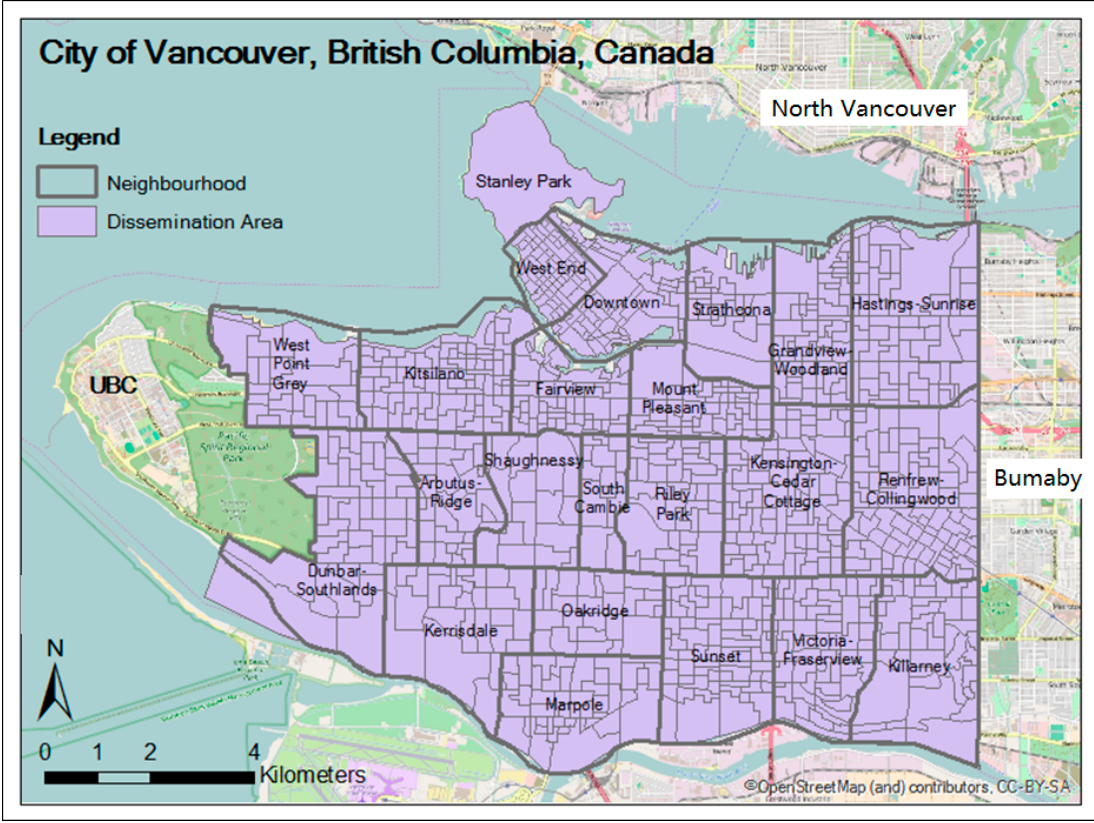
Figure 1. Study area divided into dissemination areas: City of Vancouver, British Columbia.